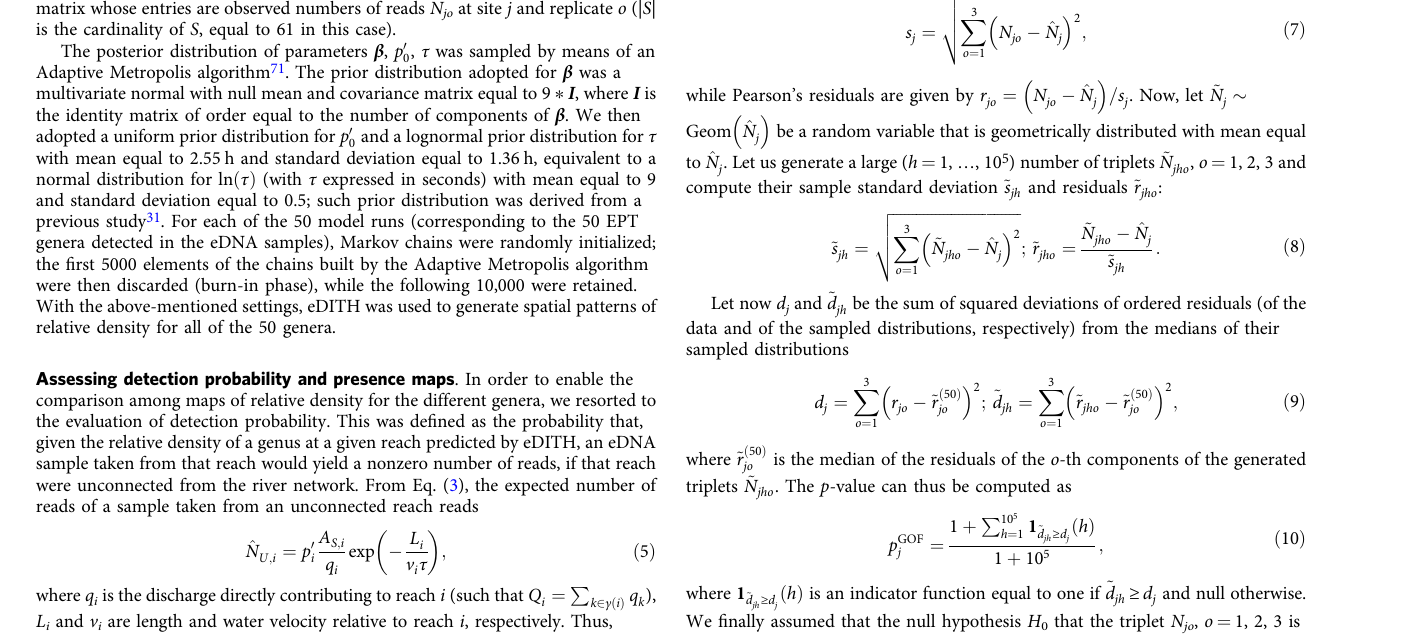
ffiffiffiffiffiffiffiffiffiffiffiffiffiffiffiffiffiffiffiffiffiffiffiffiffiffiffiffiffiffiffiffi X 3